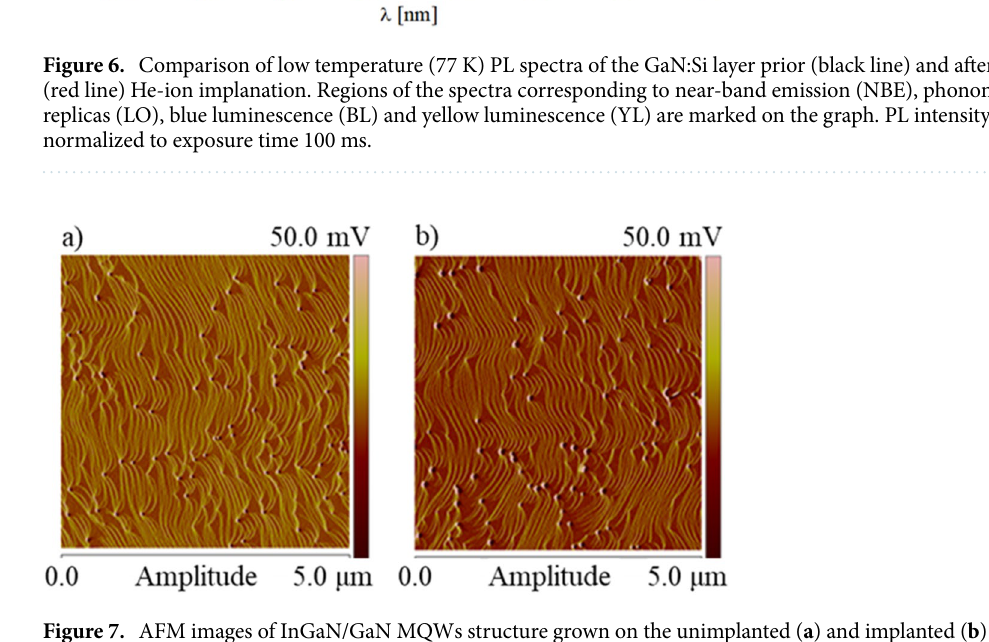
Figure 7. AFM images of InGaN/GaN MQWs structure grown on the unimplanted ( a ) and implanted ( b ) GaN:Si on the GaN:Si/sapphire